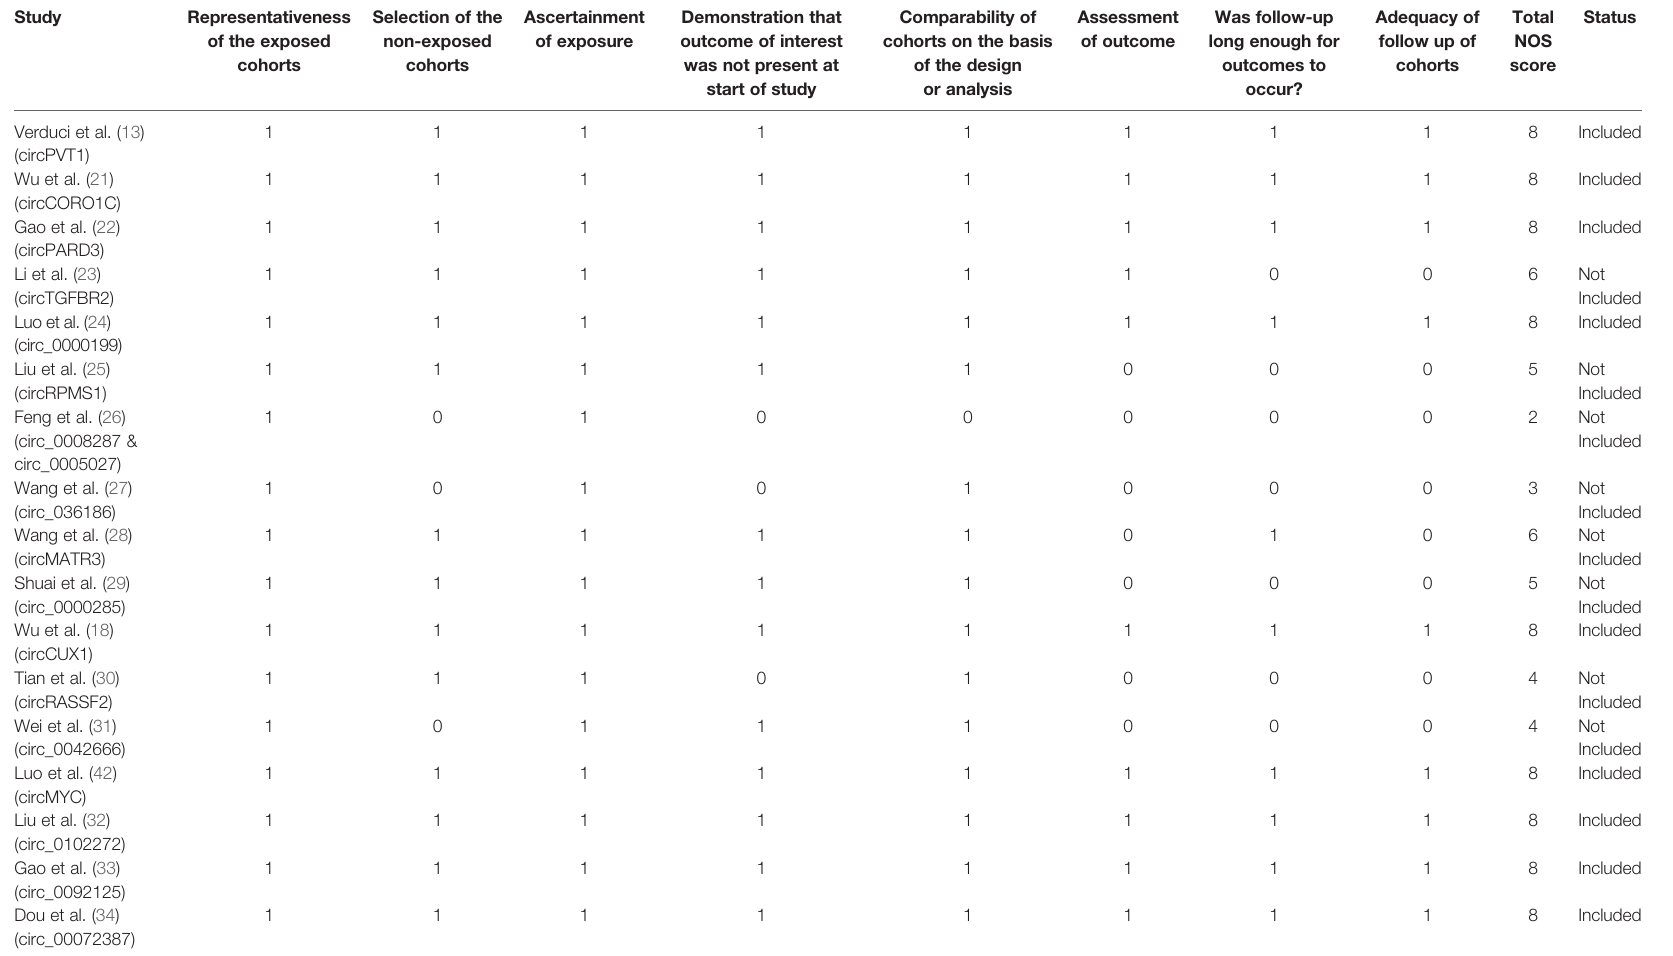
Selection of the Ascertainment of the exposed non-exposed of exposure cohorts cohorts